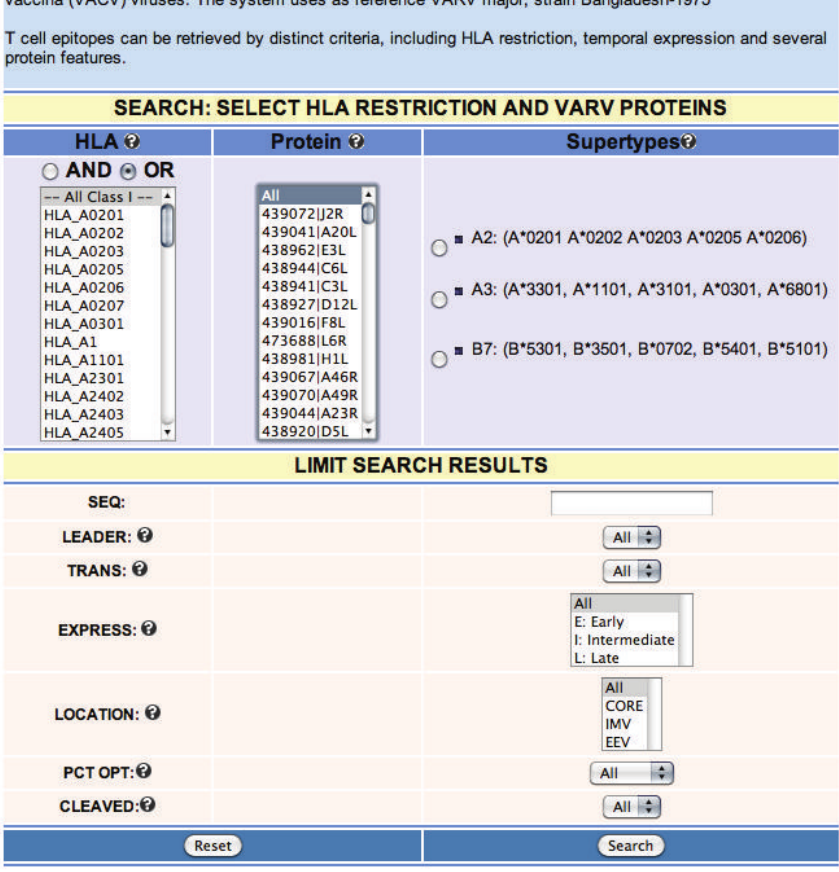
Figure 2: EPIPOX input page. The input page of EPIPOX is divided in two main sections for intuitive use. In the first part (SEARCH), users select HLA molecules and proteins to retrieve T-cell epitopes (multiple selection is allowed) while in the second part the user can limit the search output according to various criteria. These criteria include temporal expression of gene products (E: early; I: intermediate; L: late), location of proteins in relevant structures of the virus (CORE, IMV, and EEV), and the presence of leader and transmembrane regions. In addition, users can select only those peptides with a relative score above some selectable value. HLA-specific profiles used to score T-cell epitopes can reach a maximum score, which is used to set the relative score in percentage of each peptide. For HLA I-restricted epitopes, users can also restrict the search to those epitopes potentially generated by the